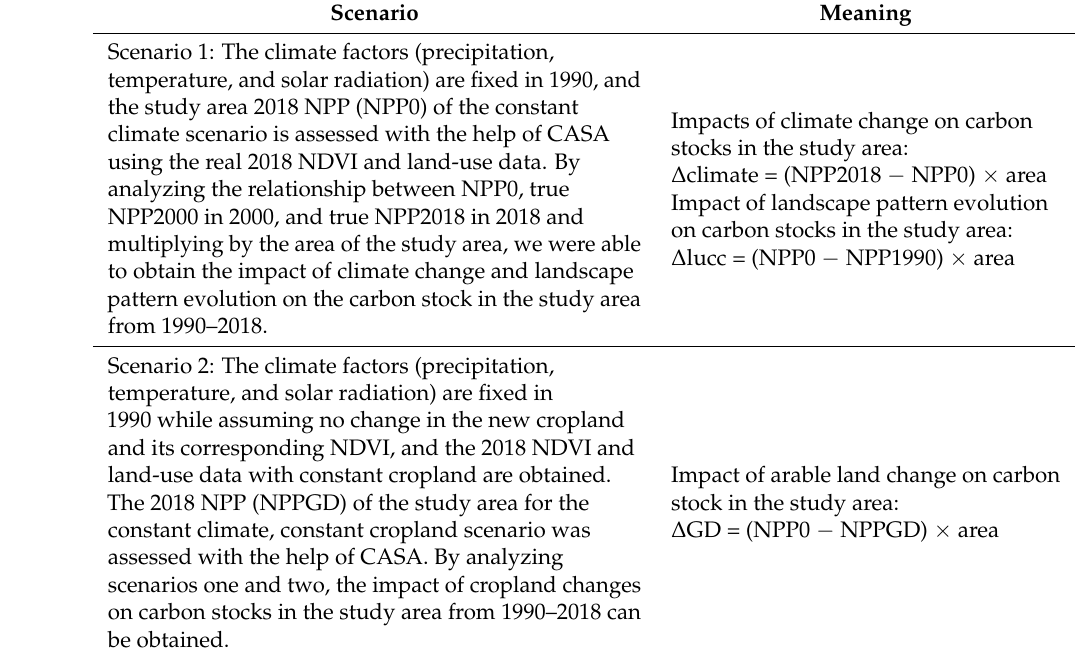
Table 3. Scenario setting and analysis. Scenario